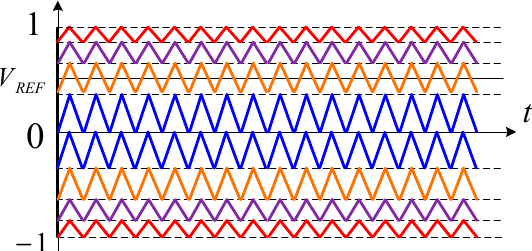
Figure 2. Four H-bridge CHB inverter LS PWM bands adjusted to match non-equal DC sources V1 > V2 > V3 > V4.